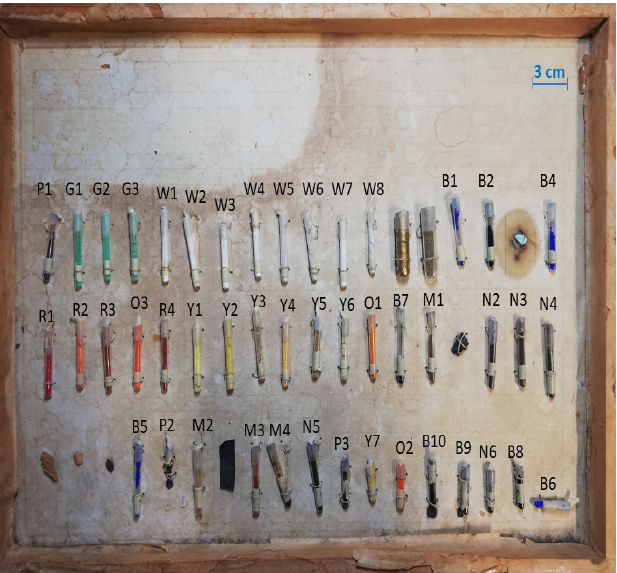
Figure 1. Historical sample-case containing examined pigments mainly enclosed in glass vials.